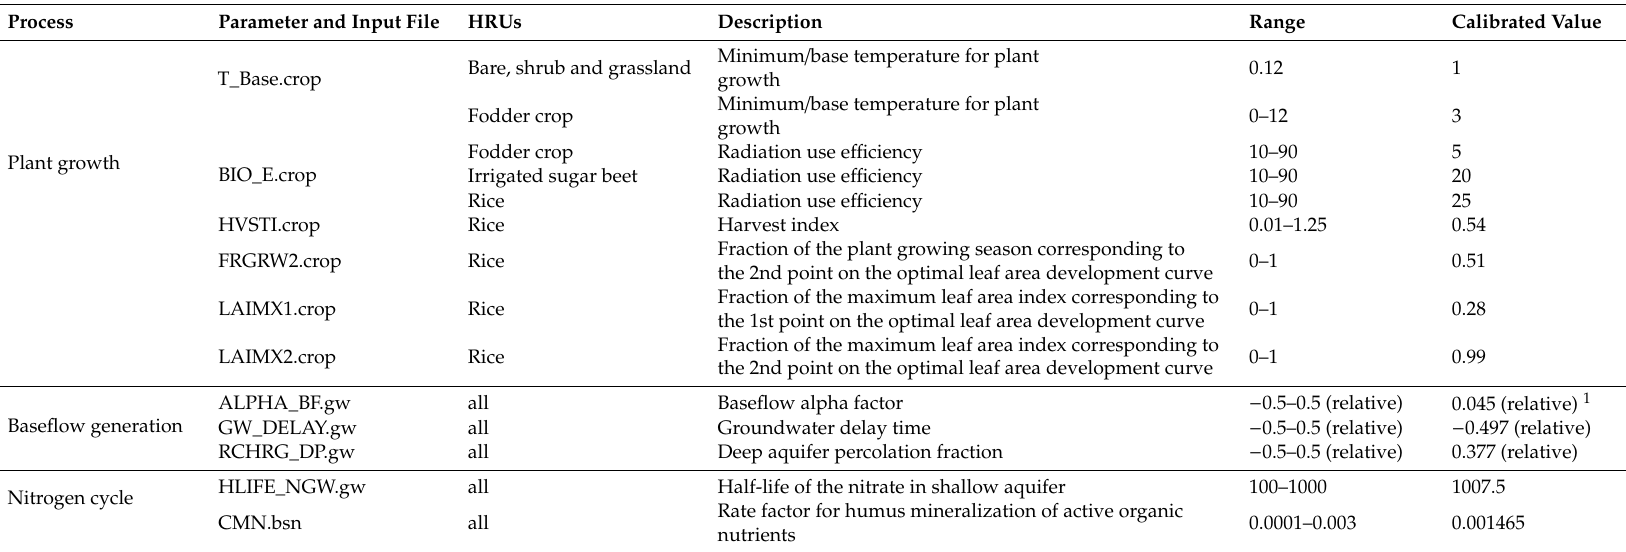
Table 4. Description of calibrated parameters involved in the calibration with their range before and after